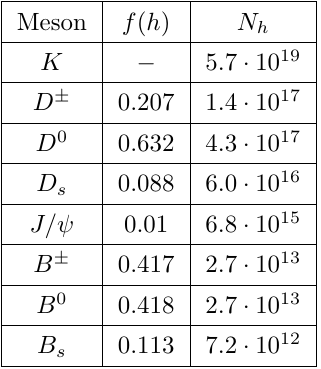
Table 15 . Production fraction and expected number of di(cid:11)erent mesons in SHiP.